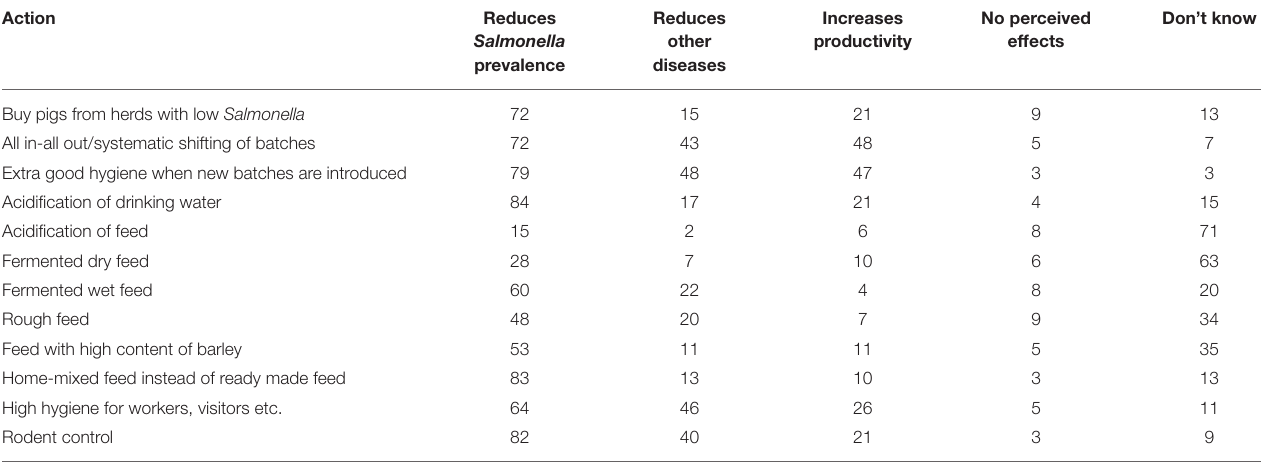
TABLE 8 | Farmers’ perception (in percent of respondents) of whether the individual actions have an effect on Salmonella level, other diseases, productivity, or no effect. Action Reduces